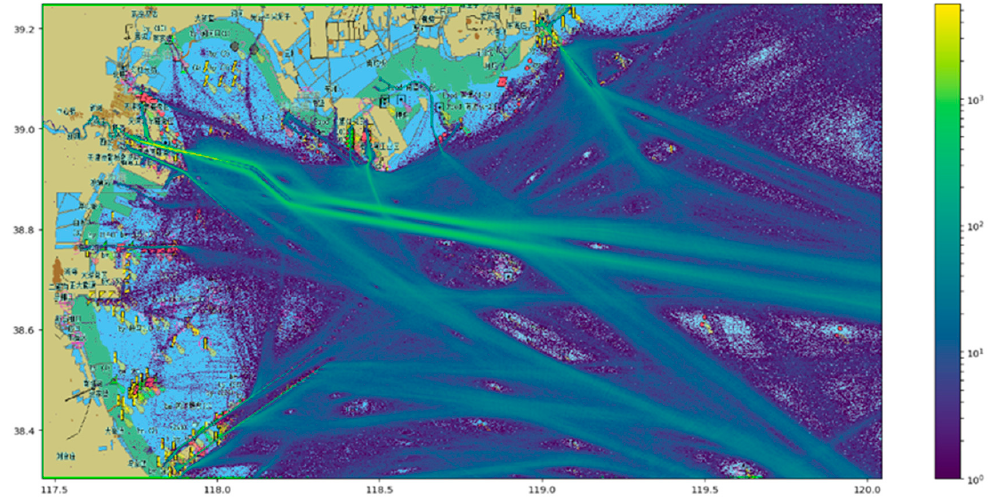
Figure 6. Before AIS data compression.